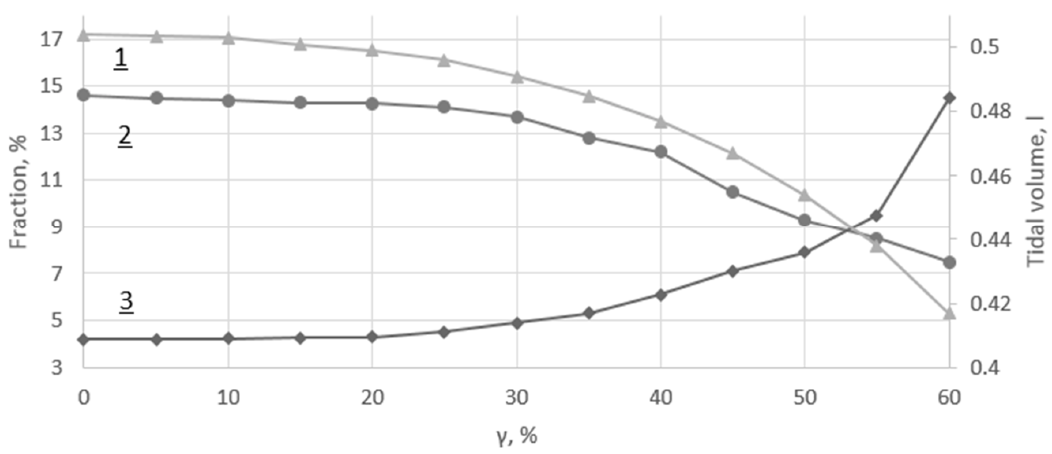
O concentration; (3) Alveolar 2